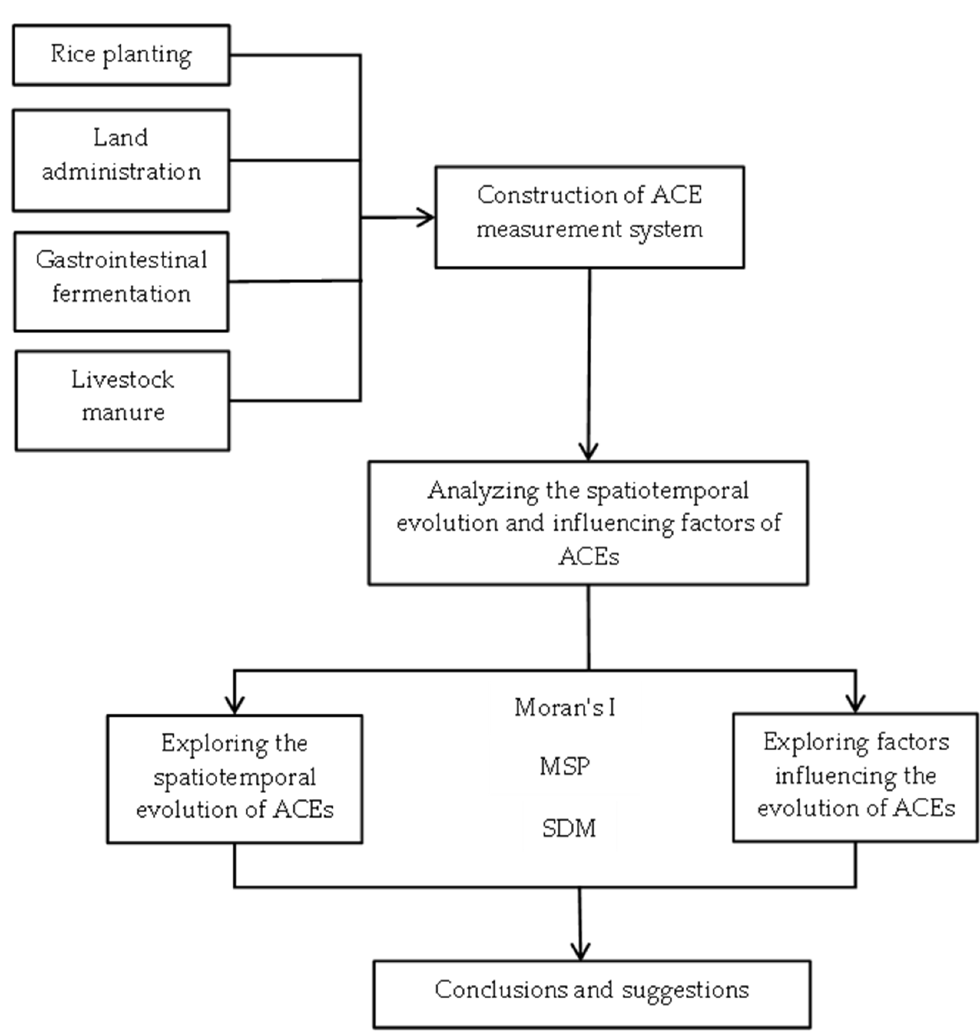
Figure 1. Analysis Framework.